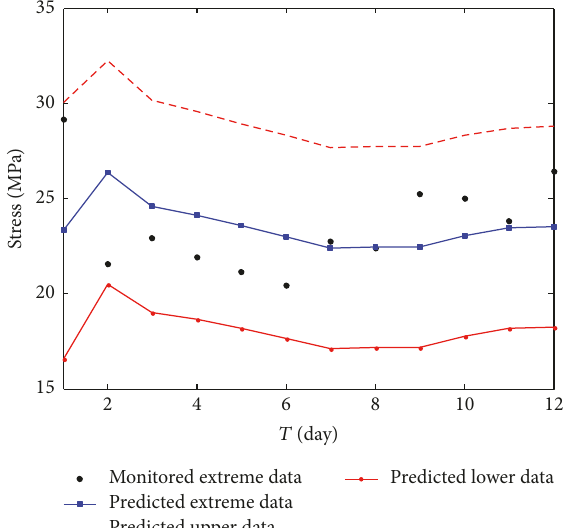
Figure 10: Single Bayesian factors of BDLM.